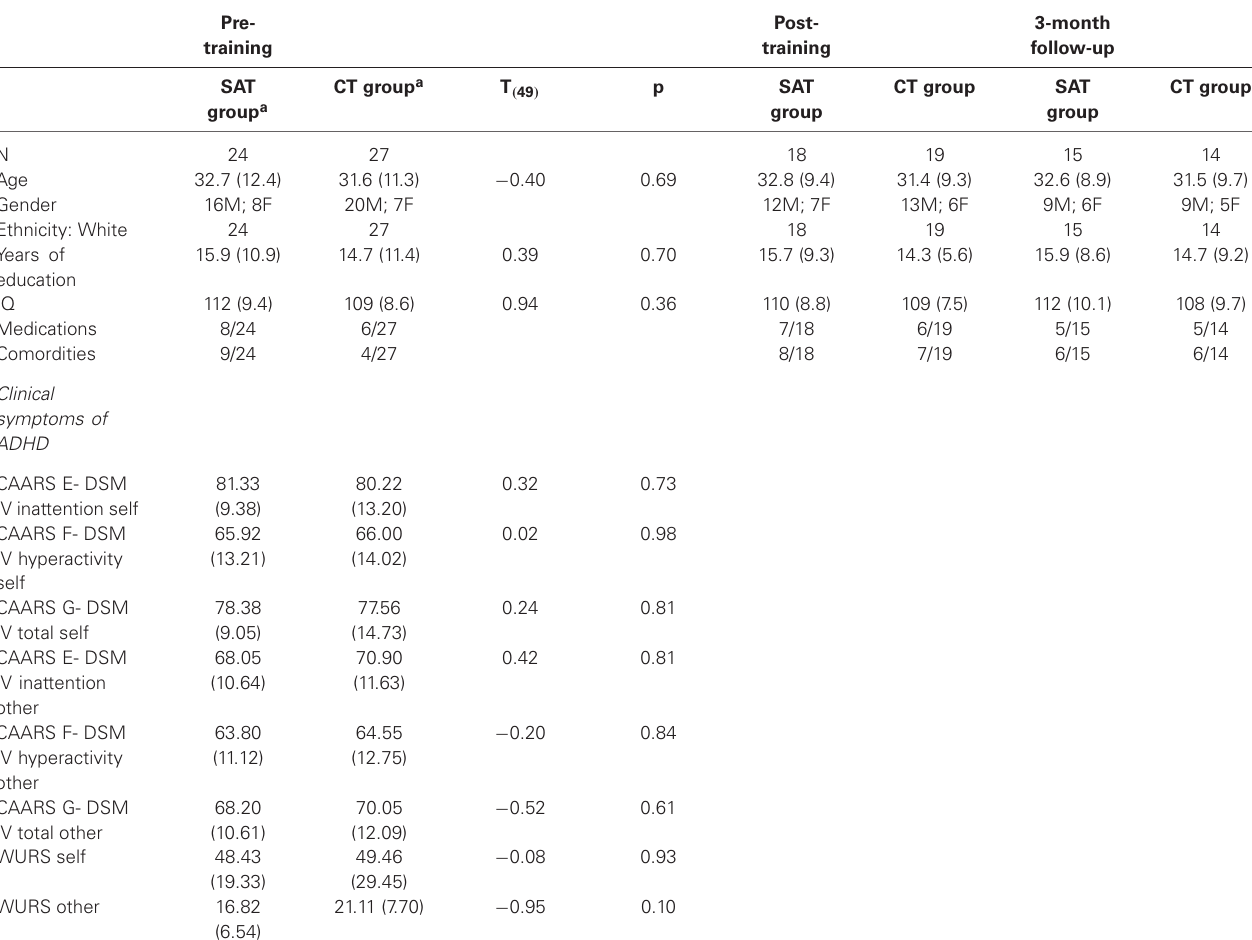
Table 1 | Demographic characteristics at the three assessment points and measures of ADHD symptoms at pre-training in the SAT group ( n = 24) and in the CT group ( n = 27)